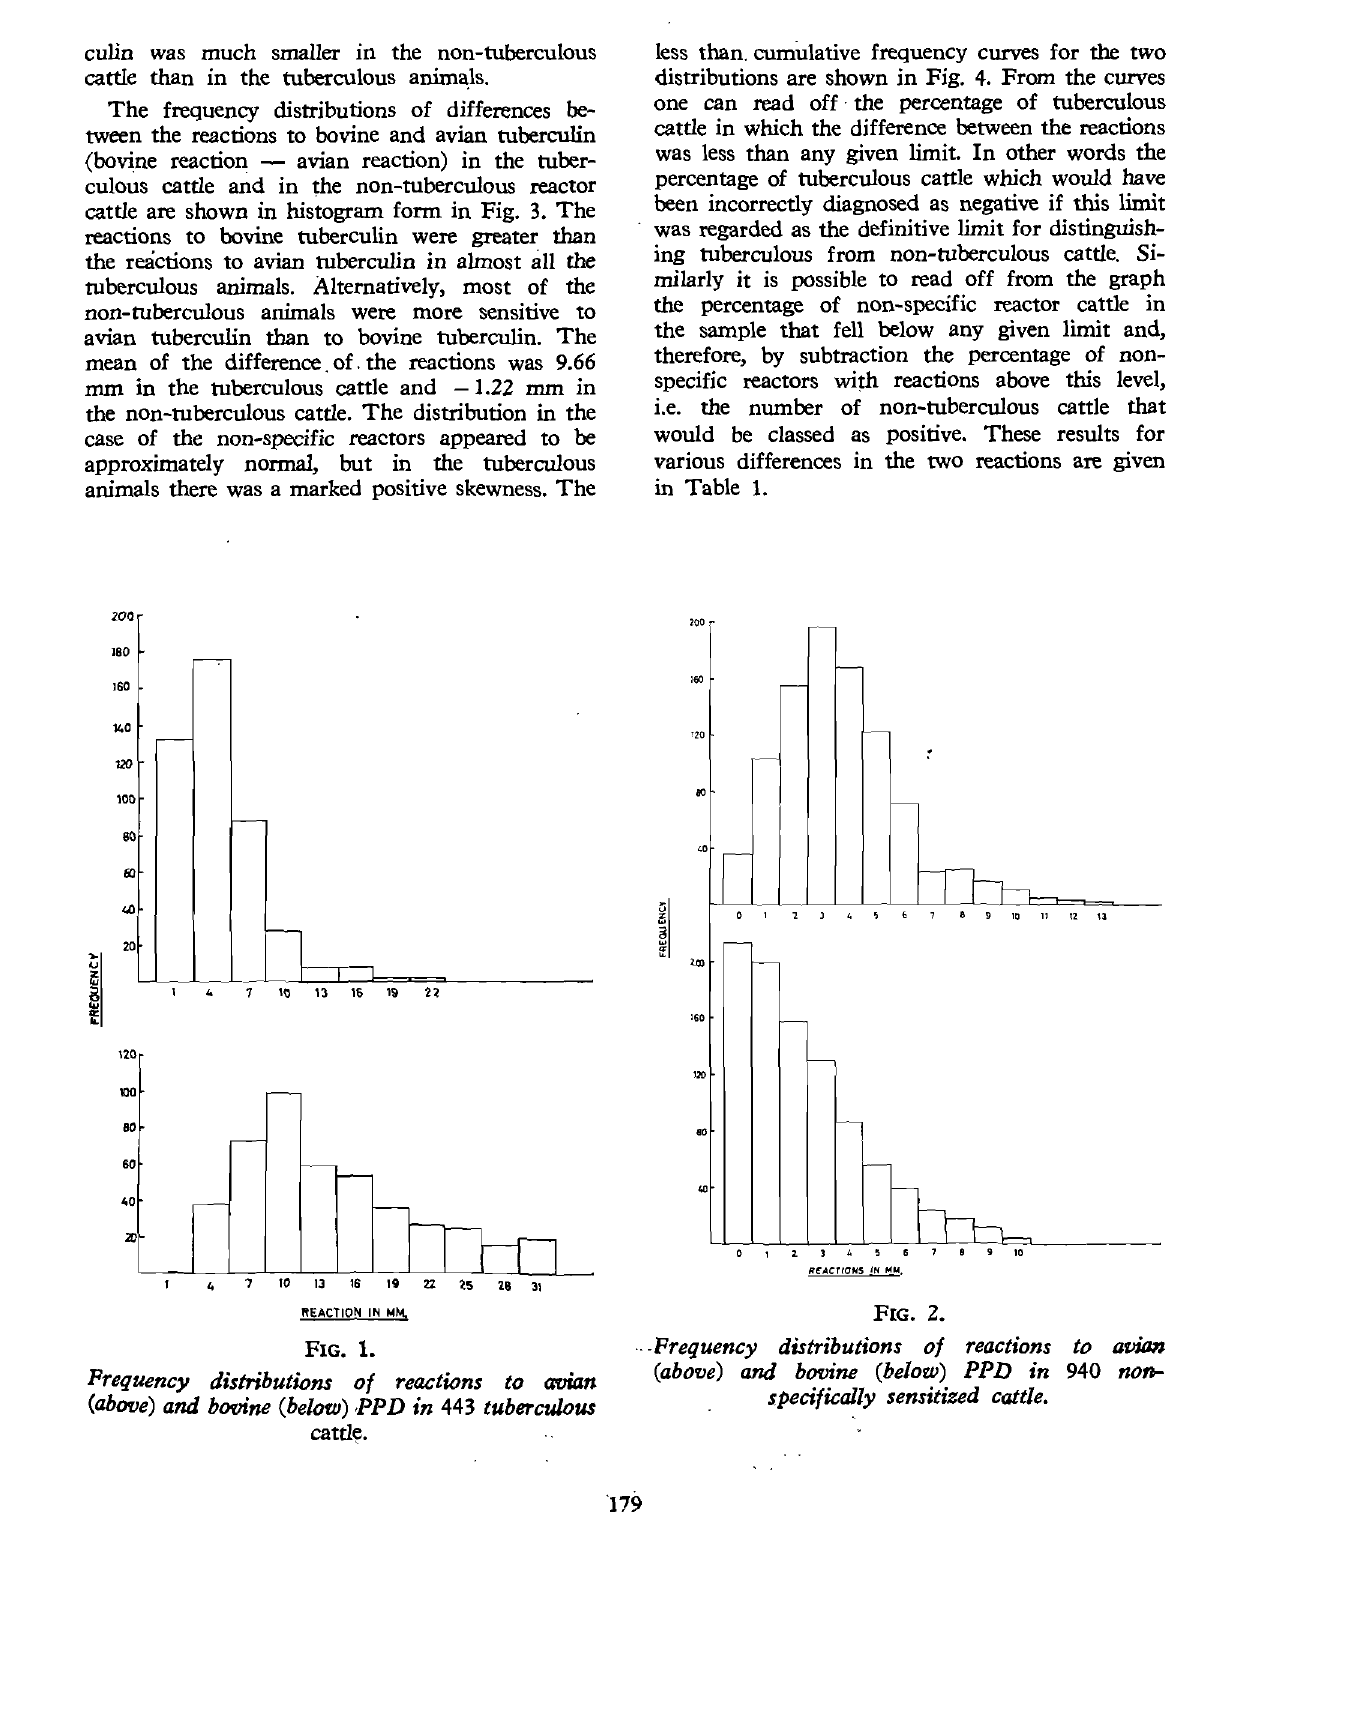
-. -Frequency distributions 0/ reactions to a'lJion (above) and booine (below) PPD in 940 non specifically sensitized cattle.